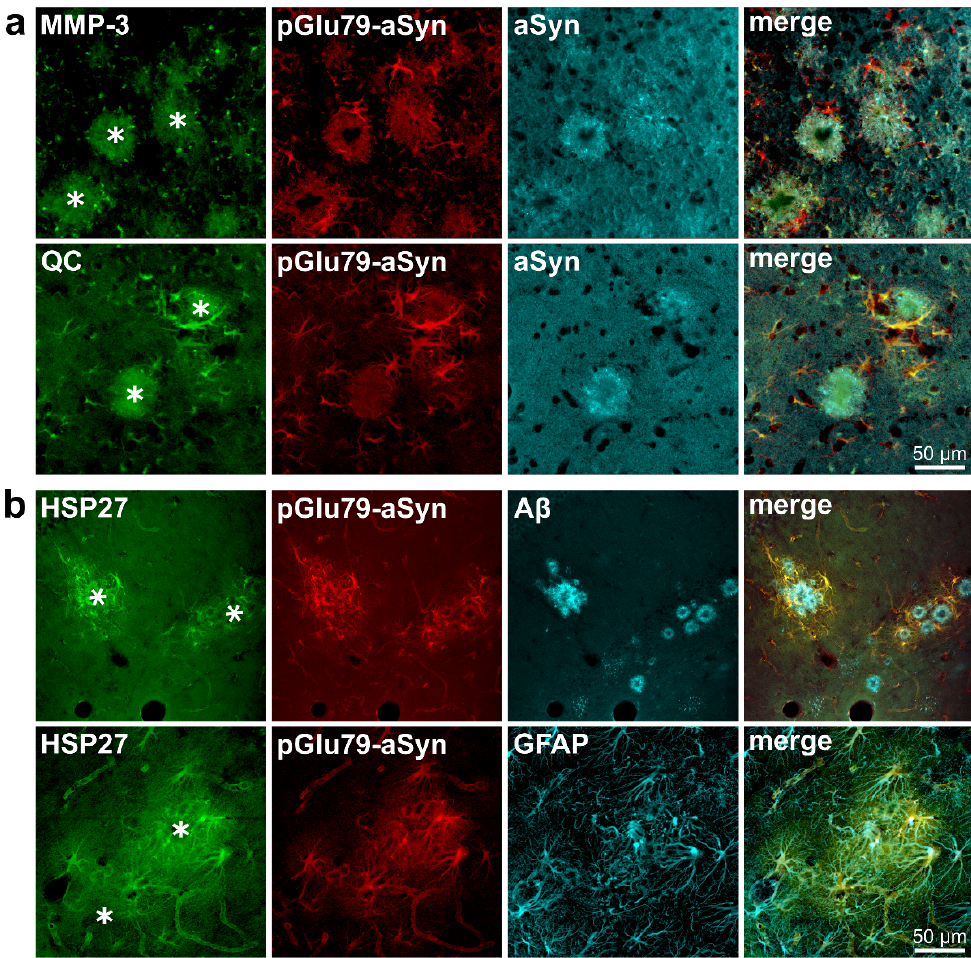
Figure 3 . Immunohistochemical detection of pGlu79-aSyn, MMP-3, QC and HSP27 in brains of wild- type and Tg2576 mice . In wild-type mouse brain ( top row ), synaptic pGlu79-aSyn, extracellular/syn- aptic MMP-3, QC-positive interneurons and vascular HSP27 were detected. In contrast, in Tg2576 mouse brain ( bottom row ), pGlu79-aSyn, QC and HSP27 were detected with different intensities in glial cells. MMP-3 and in addition QC and pGlu79-aSyn appeared as punctate or diffuse extracellu- lar aggregates in the periphery of A β plaques. The examples shown are from entorhinal cortex (pGlu79-aSyn and MMP-3) and from hippocampus (QC and HSP27).